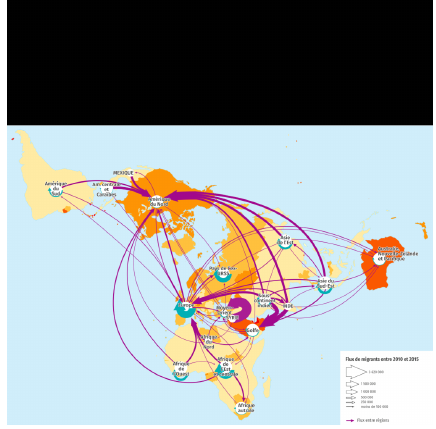
Figure 11: World map with a polar